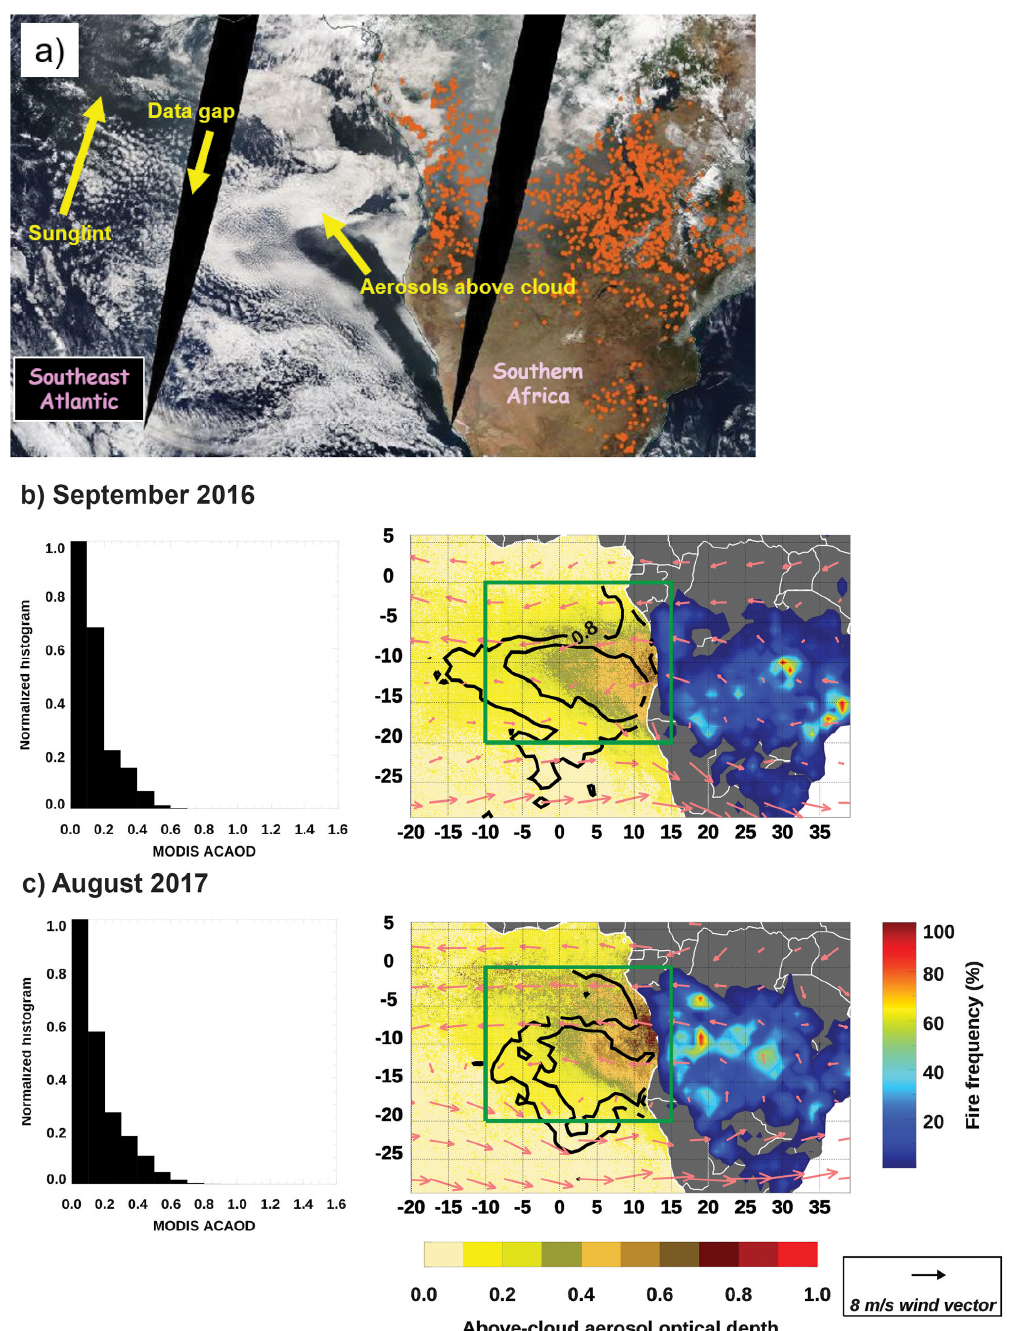
Figure 1. The MODIS Terra true-color image with fire locations (in orange) over the southeastern Atlantic and southern Africa on 12 Au- gust 2017 (a) . Monthly mean oceanic ACAOD from MODIS based on the Meyer et al. (2015) above-cloud aerosol algorithm, fire frequency (detection confidence above 70%), and maritime low-level (clouds with tops up to 2.5km altitude) cloud fractions (0.8 and 0.9) accompanied by normalized histograms of the satellite ACAOD from the regions delineated by green boxes (excluding the land) for (b) September 2016 and (c) August 2017. Pink arrows represent 600mb wind vectors from the National Centers for Environmental Prediction (NCEP) Reanalysis dataset. The satellite image is adapted from NASA EOSDIS Worldview (https://worldview.earthdata.nasa.gov/, last access: 24 October 2020).